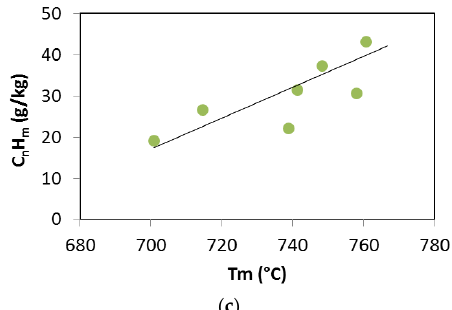
Figure 11. Gasification of almond shells (M): ( a ) Yield of tar versus ER(O 2 ); ( b ) Yield of syngas versus ER(O 2 ); ( c ) Yield of incondensable hydrocarbons versus the average temperature of the bed.